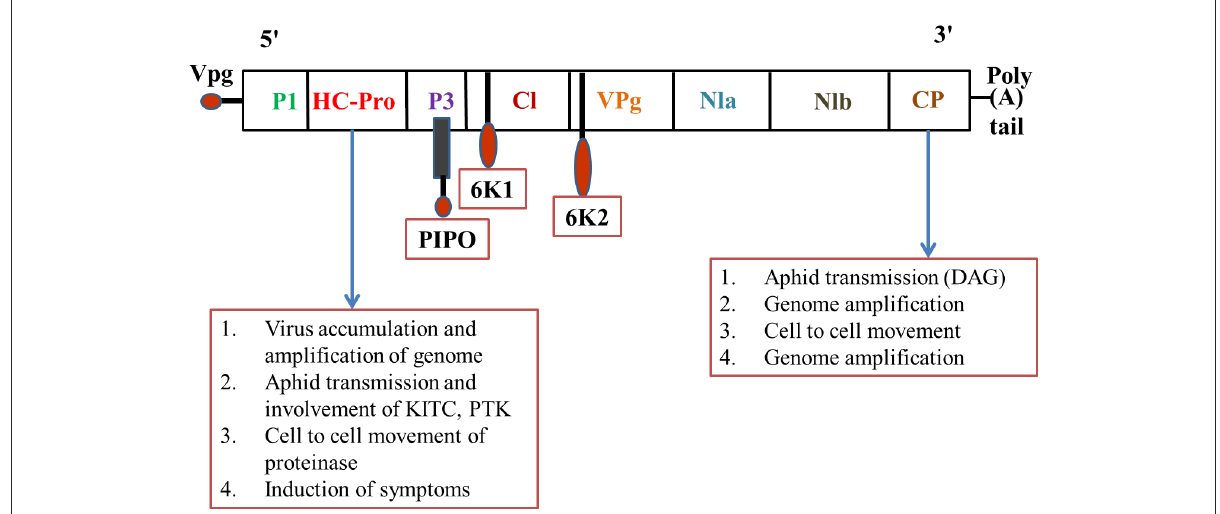
FIGURE2 Potyvirus proteins and their functions (Mishra et al., 2014). P1 Proteinase—Cell to cell movement; HC-Pro— Aphid mediated transmission, cell to cell movement; P3—Role in replication; CI—Genome replication (RNA helicase), membrane attachment, ATPase activity, cell to cell movement; VPg—Genome replication (Primer for initiation of RNA synthesis); NIa—Major Proteinase; NIb—Genome replication (RNA-dependent RNA polymerase [RdRp]); CP—RNA encapsidation, involved in vector transmission, cell to cell movement; 6K1, 6K2—Possible roles in RNA replication, regulatory function, inhibiting NIa nuclear